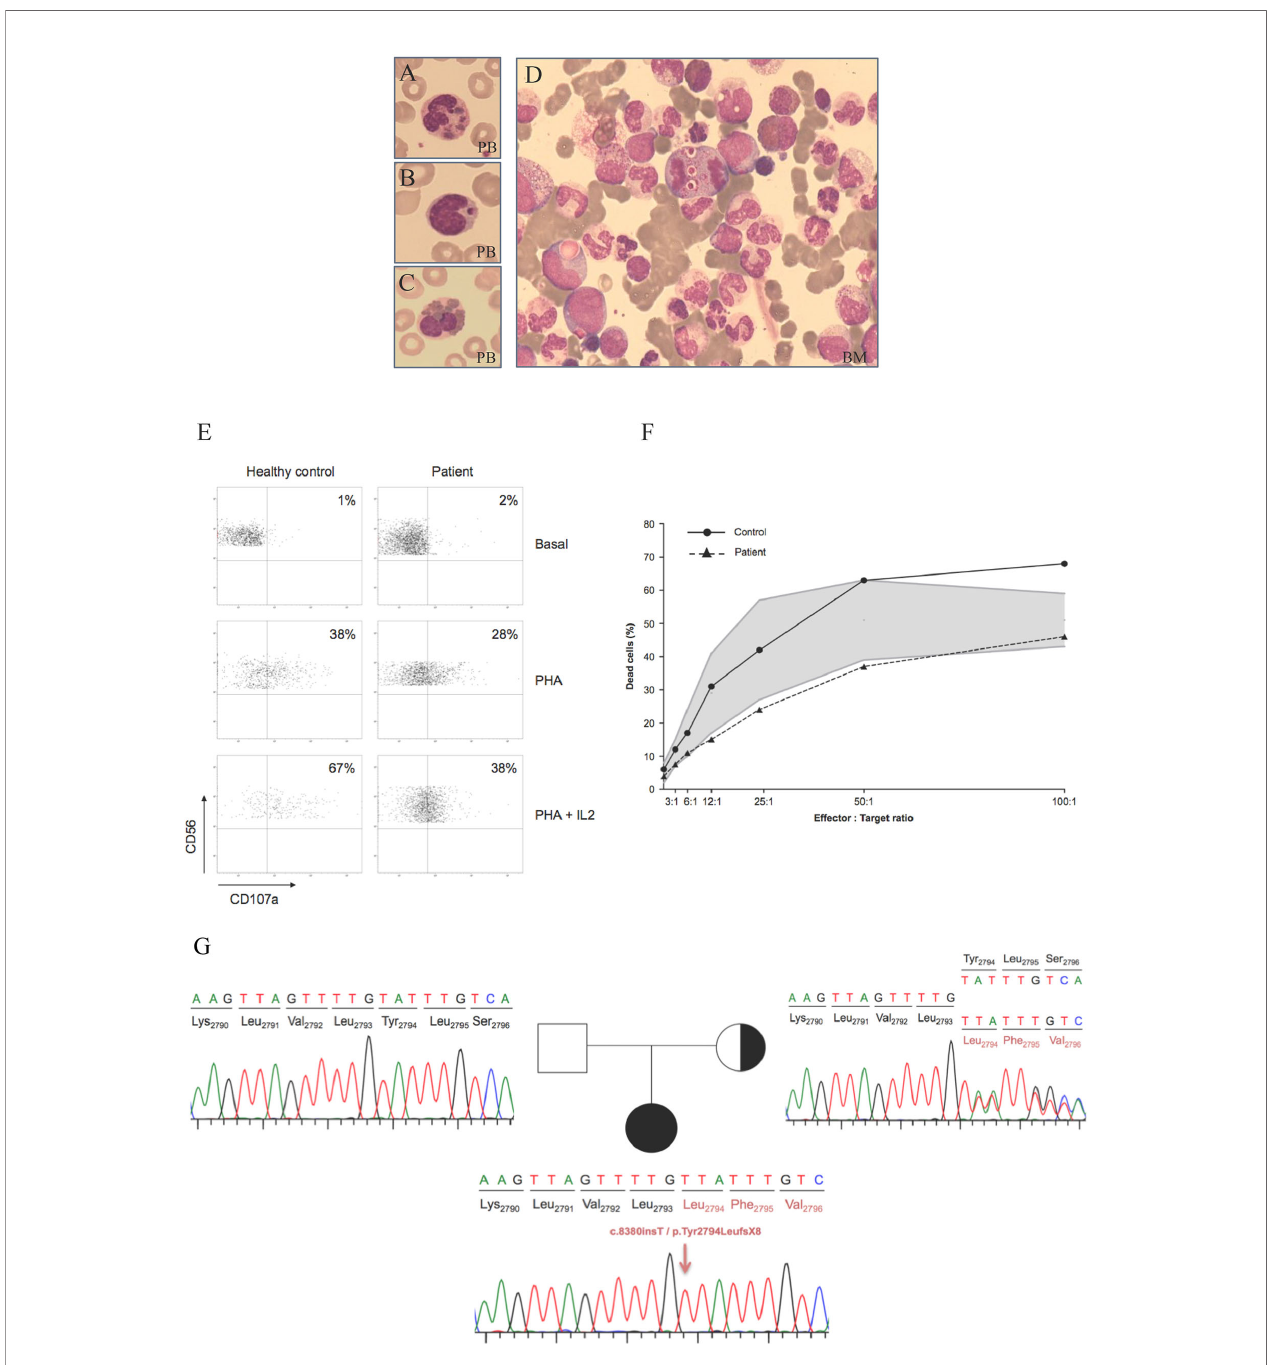
FIGURE 1 | Morphological, cellular and molecular fi ndings in the CHS patient. (A – C) Wright stains of peripheral smear showing a neutrophil, lymphocyte and eosinophil with giant intracytoplasmic granules. (D) Bone marrow aspirate. Intense vacuolization and purple inclusions are also observed in immature cells of the myeloid linage. PB: peripheral blood; BM: bone marrow. (E) Degranulation assay was decreased compared to the healthy control both with PHA and PHA + IL2. PBMCs were incubated with or without (resting cells) PHA either alone or with IL-2 for 4 hr at 37°C. Thereafter, cells were stained with fl uorochrome-conjugated anti- CD56, and anti-CD107a mAbs. CD107a surface expression was gated on CD56 cells. (F) A fl ow cytometry-based NK cytotoxicity assay was performed by measuring cytotoxicity against K562 cell line in a 4-hour staining with propidium iodide. The shaded area indicates normal ranges of cytotoxicity tested in healthy individuals. The patient showed a cytotoxic function on the lower range of normality. (G) Family tree and sequence analysis of the patient and his parents. Sequence patterns showing the patient ’ s mutation c.8380dupT in homozygosis, the normal sequence of the non-carrier father and the mother ’ s sequence showing the mutation in